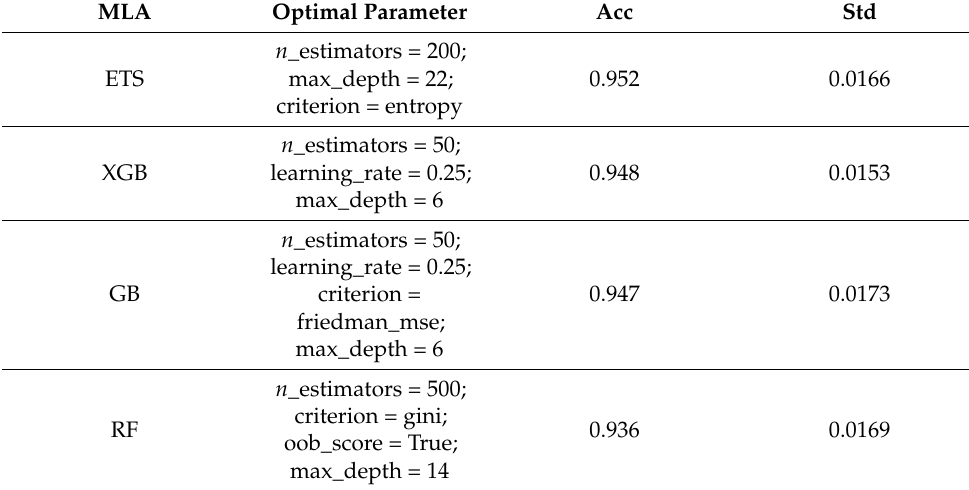
Table 3. Optimization results of models.